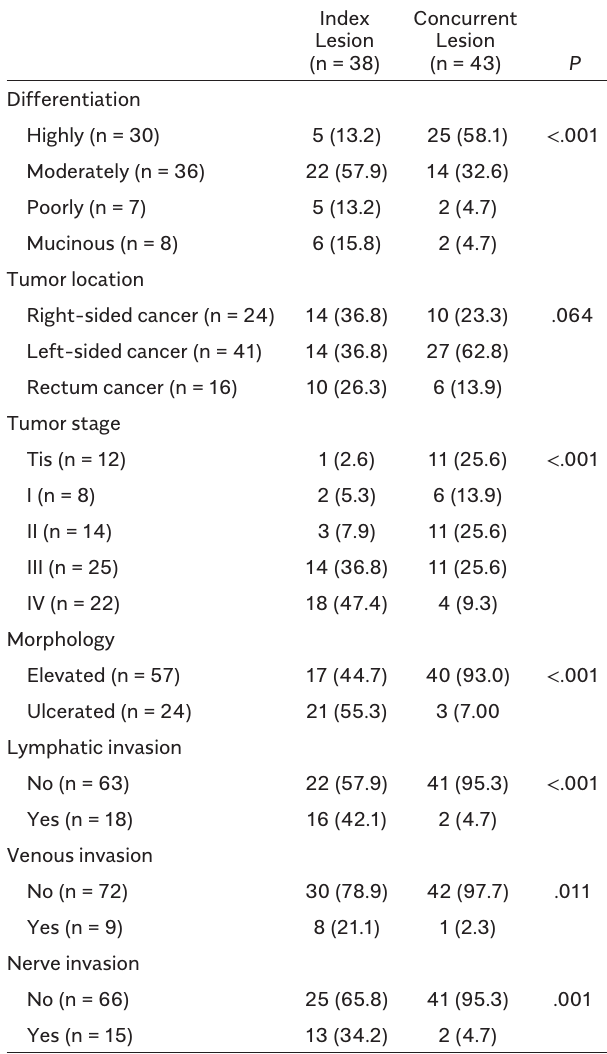
Table 2. Comparison of Pathological Findings Between Index Lesions and Concurrent Lesions in